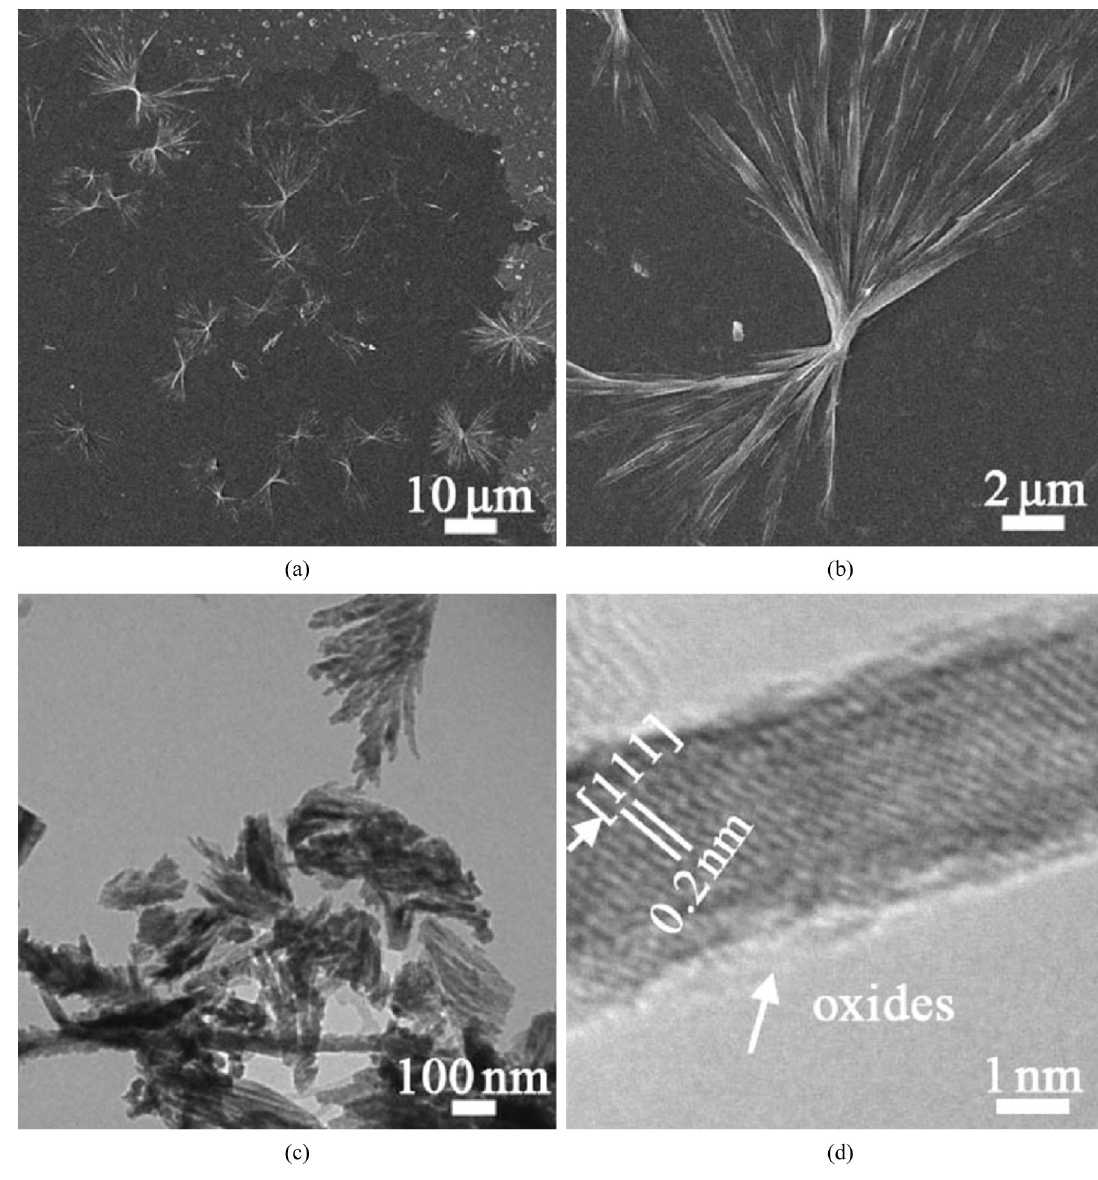
Figure 2. (a) SEM image and (b) high magnified SEM image of the products; (c) TEM image and (d) HRTEM image of the